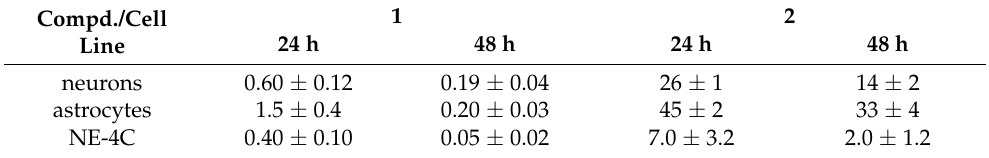
Table 2. Inhibitory concentrations IC 50 ( µ M) 1 of 1 and 2 in non-malignant brain-derived cells. Compd./Cell